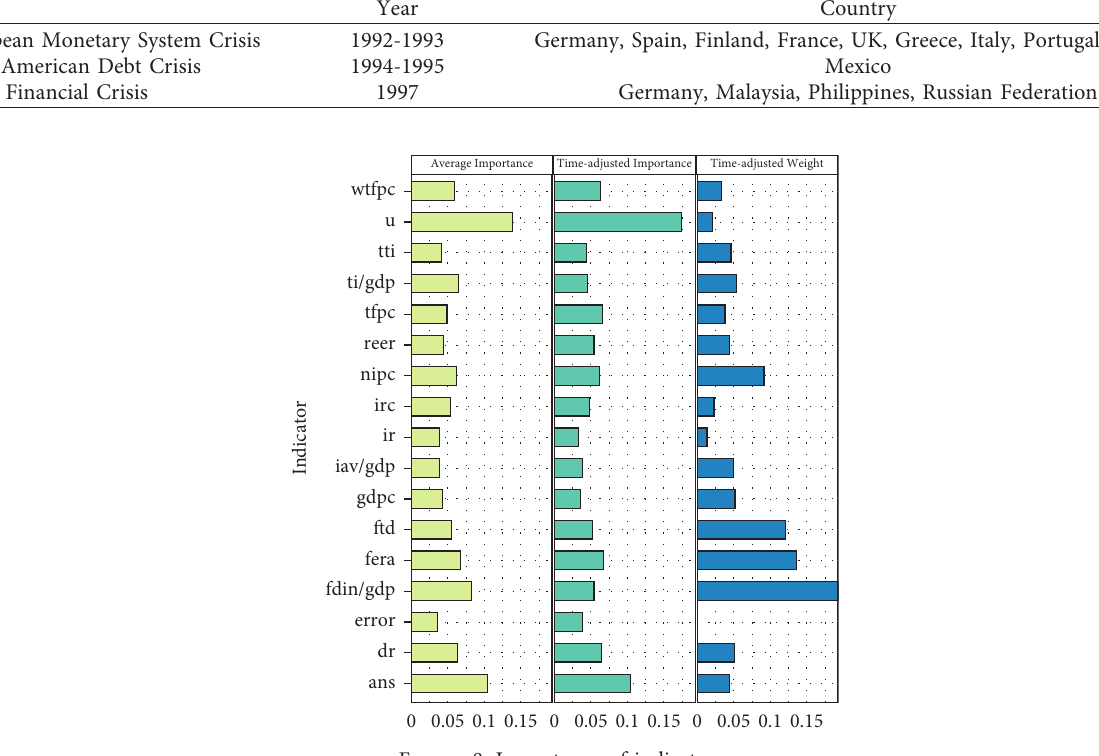
Figure 8: Importance of